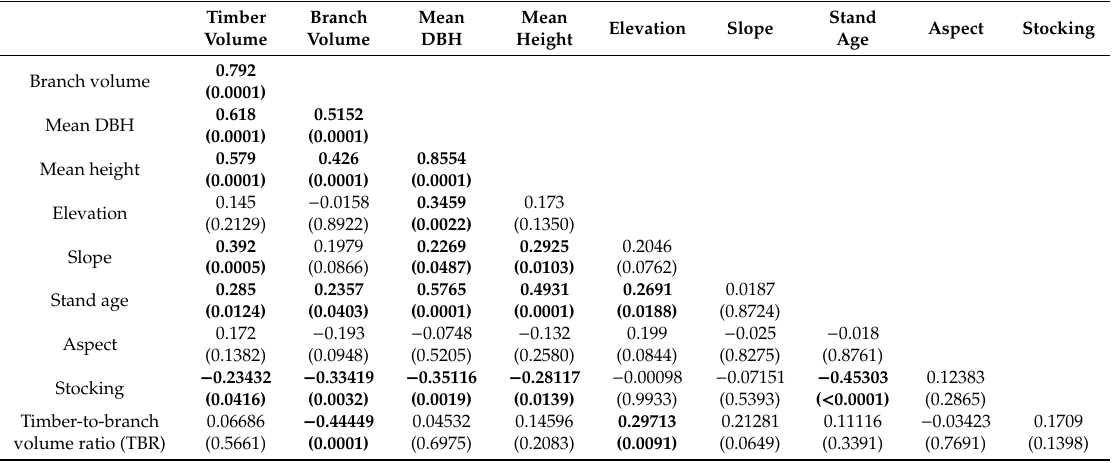
Table 2. Pearson’s correlations between various variables of the interest. Approximate p -value of each correlation is given in the parenthesis, and significant correlation is shown in